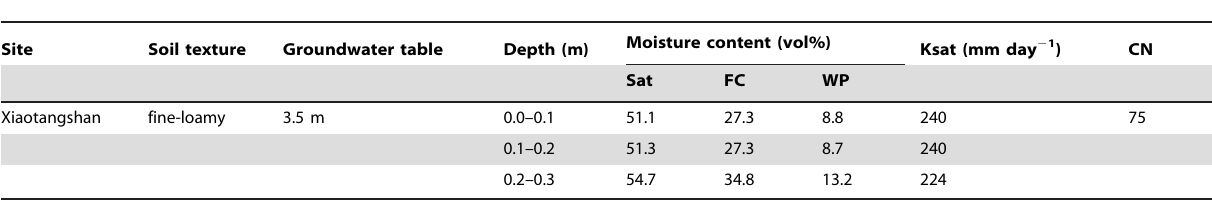
Table 3. Physical soil characteristics of the Xiaotangshan experimental site.